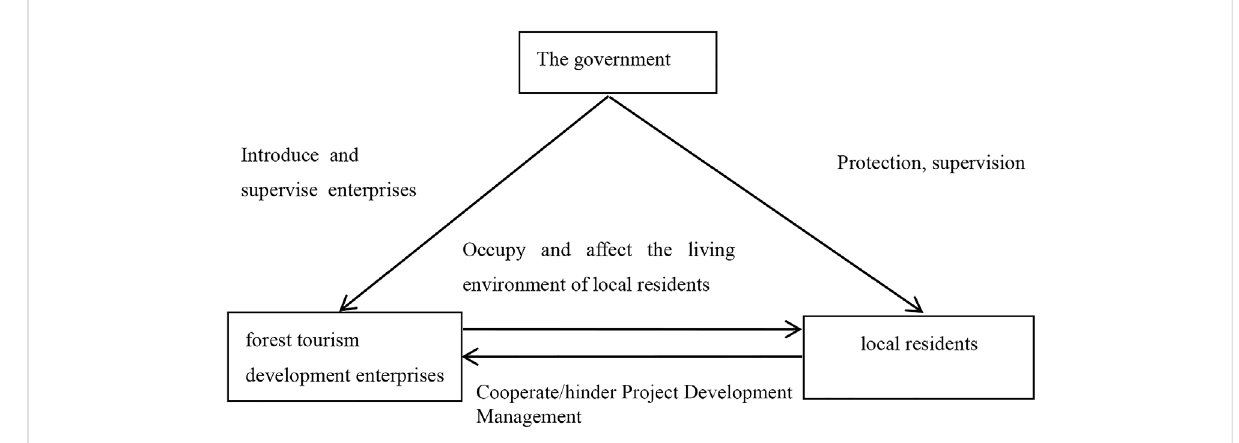
FIGURE 1 Frame graph of the relationship between main interests of forest tourism